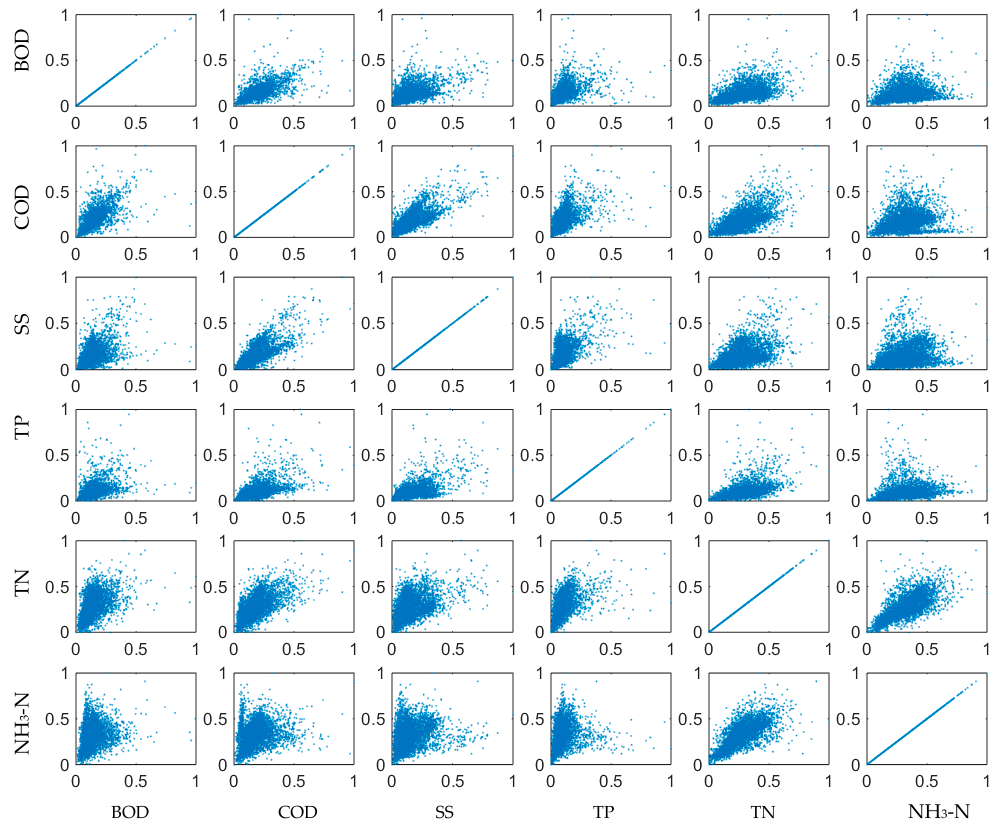
Figure 2. Cross-correlation is diverse between the six derived parameters (sludge removal loading rates) in the data warehouse. The parameters are normalized to [0,1] by interpolating the parameter over the range of minimum to maximum values in the data warehouse. BOD—biological oxygen demand; COD—chemical oxygen demand; SS—suspended solids; TP—total phosphorus; TN—total nitrogen; NH 3 -N—ammonia nitrogen.